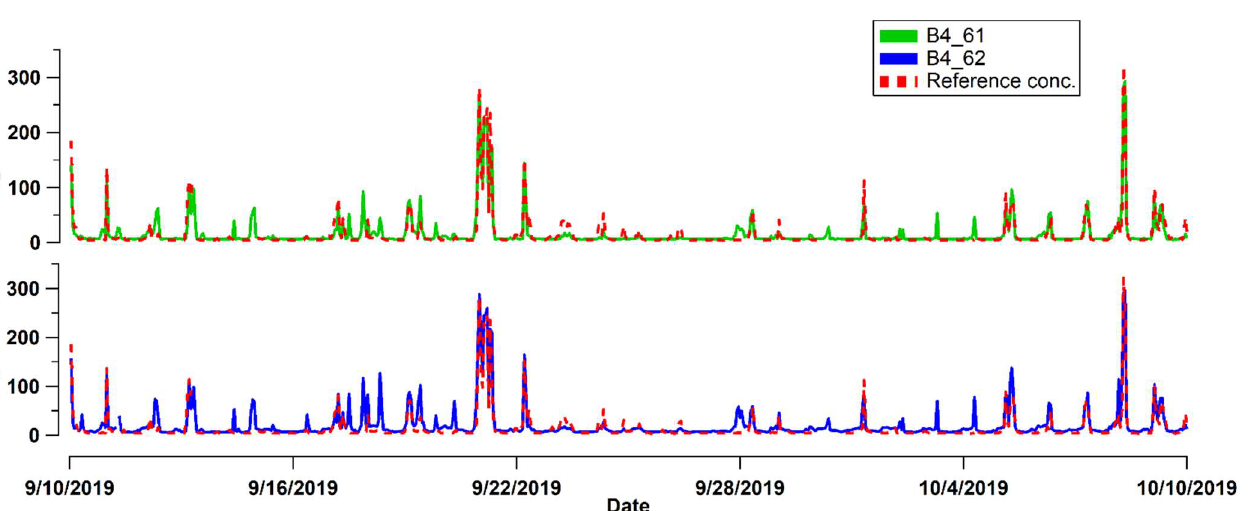
Figure 11. Time series of the 1-h average concentrations of SO 2 and NO 2 measured in the test cam- paign. 4. Discussion Low-cost sensor technology is becoming widespread in citizen science, particularly for the analysis of air quality. This article presents a training and testing method to cali- brate a custom-built air quality sensor assembled from electrochemical sensors for SO 2 and NO 2 (Alphasense B4 and B43F series). Training and testing were conducted in the field by placing the sensors next to the reference monitors. The raw responses from the electrochemical sensors (mV) were subjected to multiple linear regression (MLR) in three data segments. The data segmentation methodology and subsequent application of mul- tiple regression allowed the construction of models that corrected the raw responses of the sensors. This method avoids poor data fitting, as the sensors tend to behave differently in different temperature or voltage ranges. For example, strong temperature dependence was evident for the NO 2 sensors. The fit of the models for the data obtained at lower tem- peratures (i.e., the first quartile of data) generated higher R 2 . However, the fit of the NO 2 sensor data and the reference measurements became weaker as the temperature increased. Like humidity in the air, temperature can affect sensor performance. It has been shown